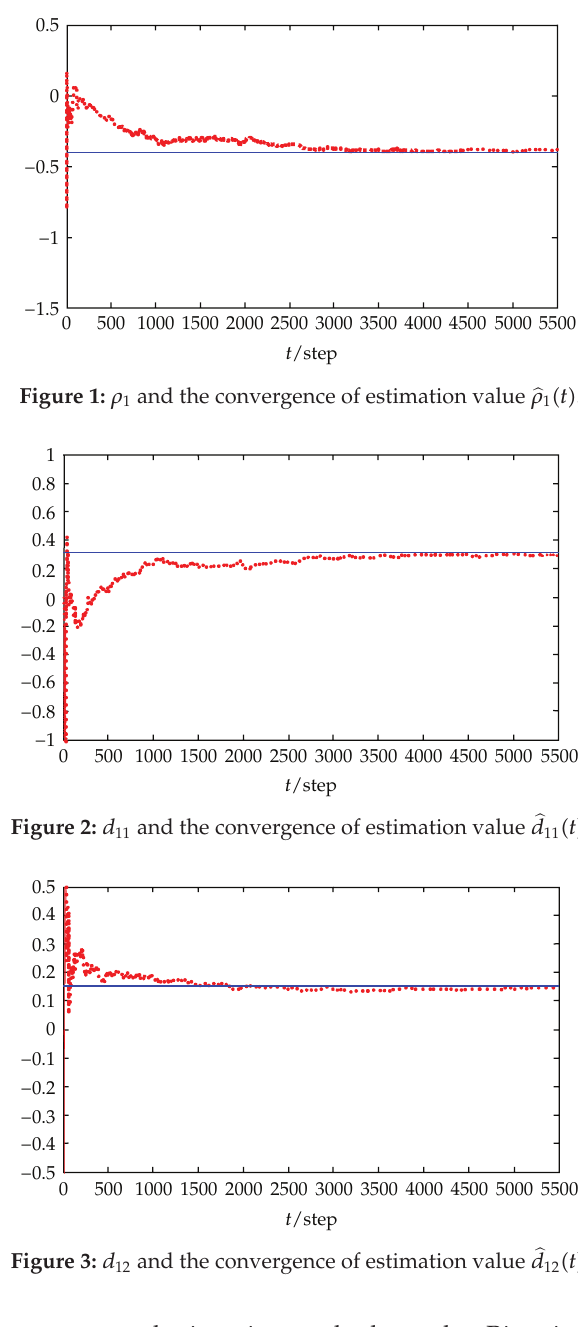
Figure 3: d 12 and the convergence of estimation value